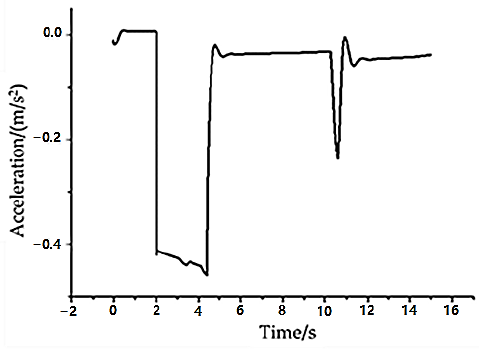
Figure 11. Acceleration change in the self-driving in CCRm test.